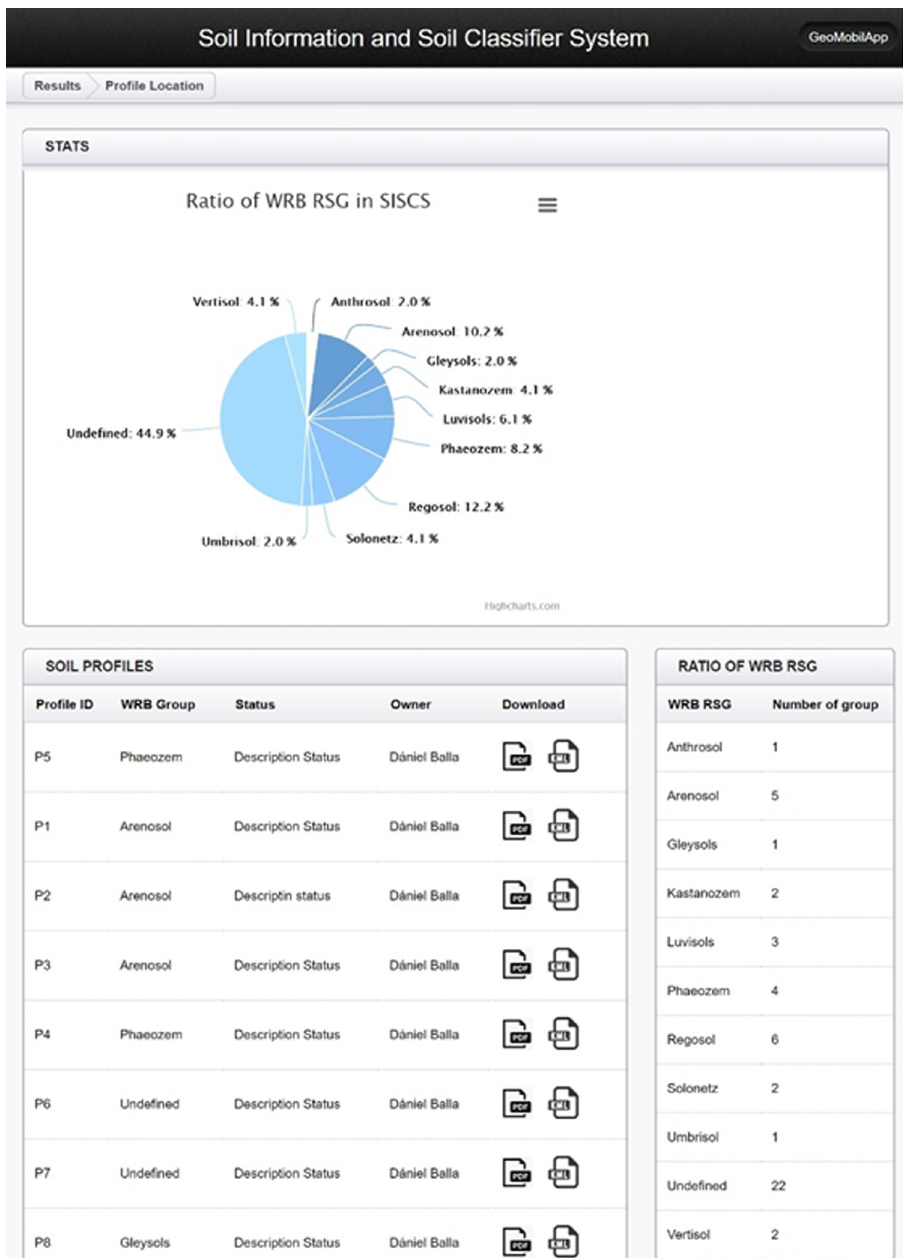
Figure 8: Interface of Result